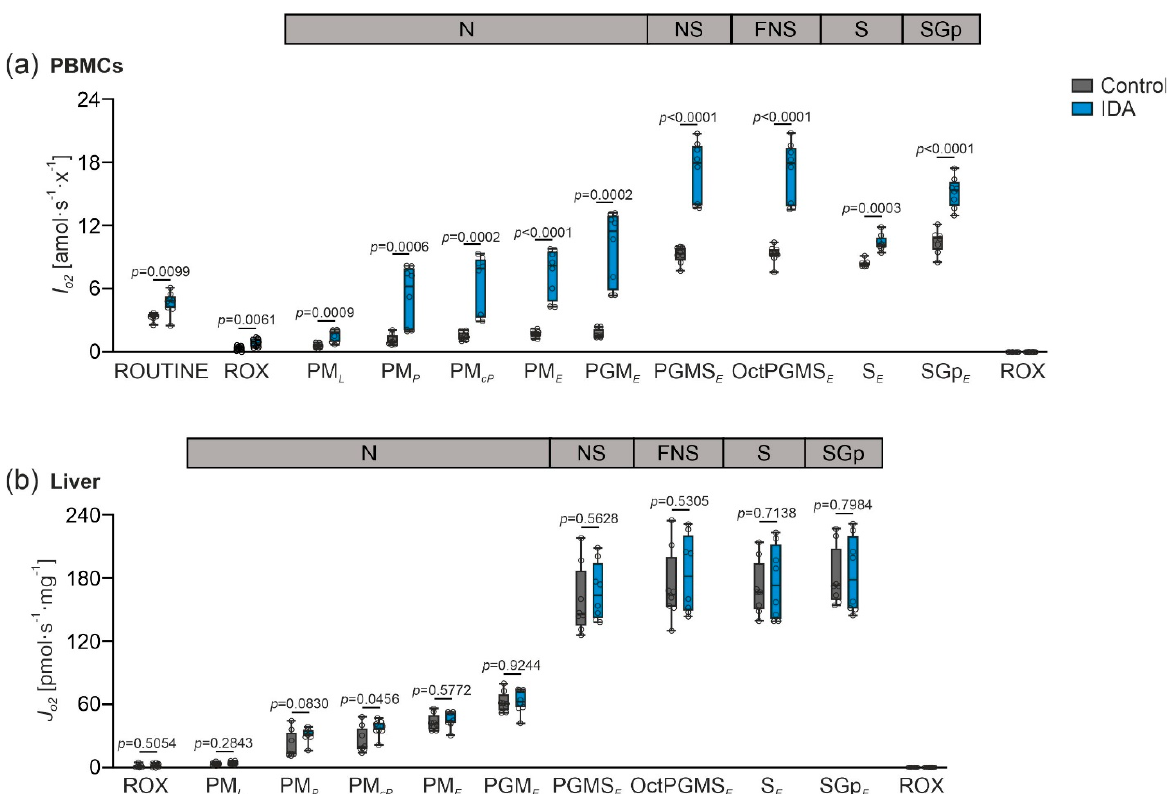
Figure 2. Effects of IDA on mitochondrial respiration in rat peripheral blood mononuclear cells (PBMCs) and liver. ( a ) Mitochondrial respiratory capacity in PBMCs with sequential titrations expressed as flow per cell ( I O2 [amol · s − 1 · x − 1 ]); ROUTINE respiration measured in presence of isolated living PBMCs. Permeabilization of plasma membrane using digitonin: residual oxygen consumption ( Rox , state ROX); pyruvate and malate (PM) in absence of adenosine diphosphate (ADP)- detecting NADH (N)-linked LEAK respiration ( L ), state PM L ; kinetically saturating concentration of ADP-detecting OXPHOS capacity ( P ), state PM P ; cytochrome c (c) for detection of mitochondrial outer membrane integrity, state PM cP ; uncoupler titrations measuring electron transfer (ET) capacity ( E ), state PM E ; glutamate (G) to measure N-linked ET capacity, state PGM E ; succinate (S) to detect NS-linked ET capacity, state PGMS E ; octanoylcarnitine (Oct) measuring FNS-linked ET capacity, state OctPGMS E ; complex I inhibitor rotenone for detection of S-ET capacity, state S E ; glycerol-3- phosphate (Gp) analyzing SGp-ET capacity, state SGp E ; antimycin A measuring Rox (state ROX). ( b ) Mitochondrial respiratory capacity in the liver with sequential titrations expressed as flux per mass ( J O2 [pmol · s − 1 · mg − 1 ]); Rox measured in the presence of liver homogenate; PM in the absence of ADP-detecting N-linked LEAK respiration, state PM L ; kinetically saturating concentration of ADP- detecting OXPHOS capacity, state PM P ; c for detection of mitochondrial outer membrane integrity, state PM cP ; uncoupler titrations detecting ET capacity, state PM E ; G to detect N-linked ET capacity, state PGM E ; S to measure NS-linked ET capacity, state PGMS E ; Oct to measure FNS-linked ET capacity, state OctPGMS E ; rotenone to detect S-ET capacity, state S E ; Gp to analyze SGp-ET capacity, state SGp E ; antimycin A to measure Rox (state ROX). N = 8 rats per group. An unpaired two-tailed Student’s t -test was applied for all normal distributed states; a Mann-Whitney U-test was applied for the nonparametric states ( a ) PM P , PM cP , PGM E , S E ; ( b ) ROX, PM P , SGp E . Values are shown as median ± interquartile range. p -Values are shown in the